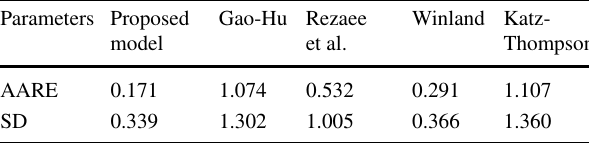
Table 2 The absolute average relative error (AARE) and the standard deviation (SD) of the relative error of the predicted permeabilities by each correlation for carbonate